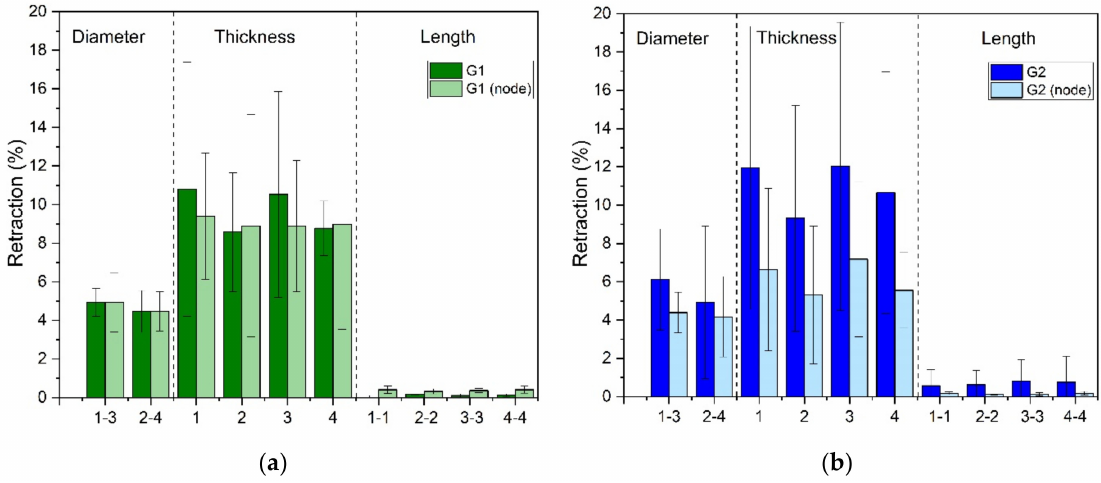
Figure 9. Linear retraction percentage: ( a ) G1 and ( b ) G2.